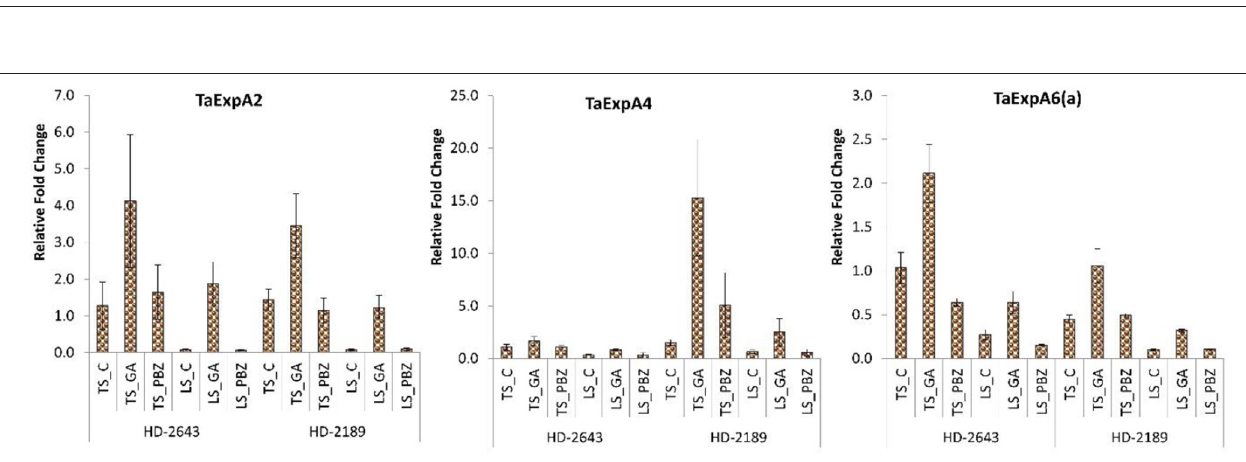
FIGURE 4 | Relative fold change in expression of wheat cell expansin genes, i.e., Ta Exp 2, Ta Exp A4, and Ta Exp A6(a) in developing grain. The error bar represents the standard error. Value on the ordinate is the mean of three replicates. On the abscissa, HD 2643, and HD 2189 are varieties; TS and LS denote timely sown and late sown of stress treatment, respectively; C, GA, and PBZ denote control, GA3, and paclobutrazol of spray treatment, respectively.